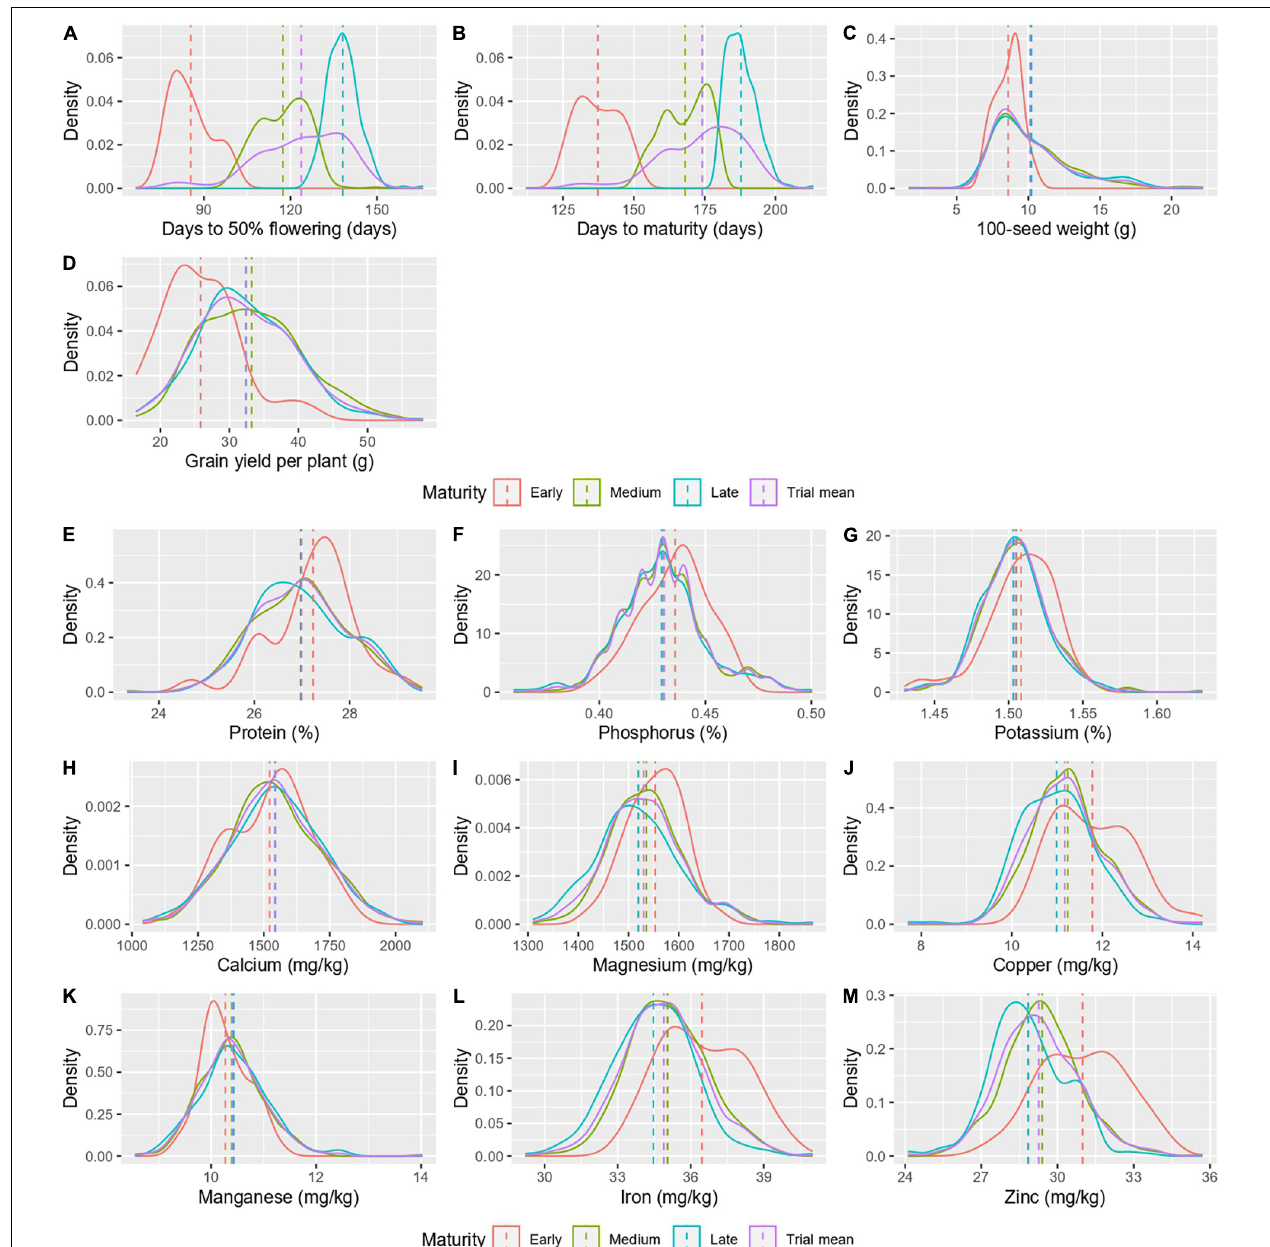
FIGURE 4 | A density graph depicting the distribution of agronomic traits (A–D) and grain nutrients (E–M) in different maturity